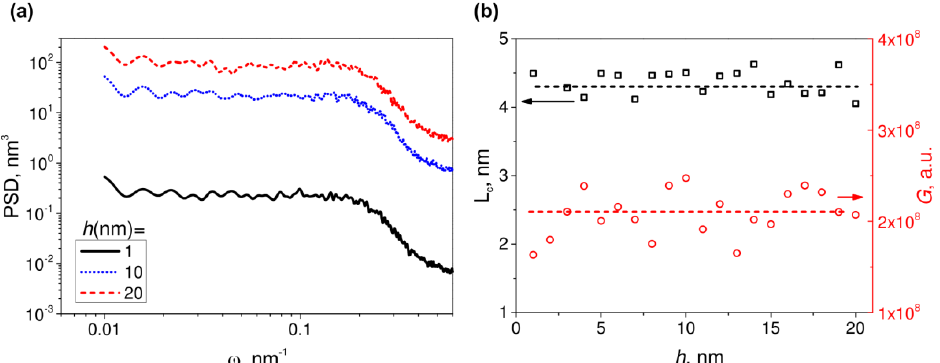
Figure 3. ( a ) Modeled PSD functions for ensembles of 1000 hemispheroidal particles with the average radius 10 nm and the radius dispersion 2 nm, randomly distributed over an area of 1 × 1 µm 2 ; height of the particles in each ensemble is 1, 10 and 20 nm. ( b ) Dependencies of the correlation length (left axis, black squares) and Raman signal (right axis, red dots) on the height of the particles. The flat lines are guides for eyes.